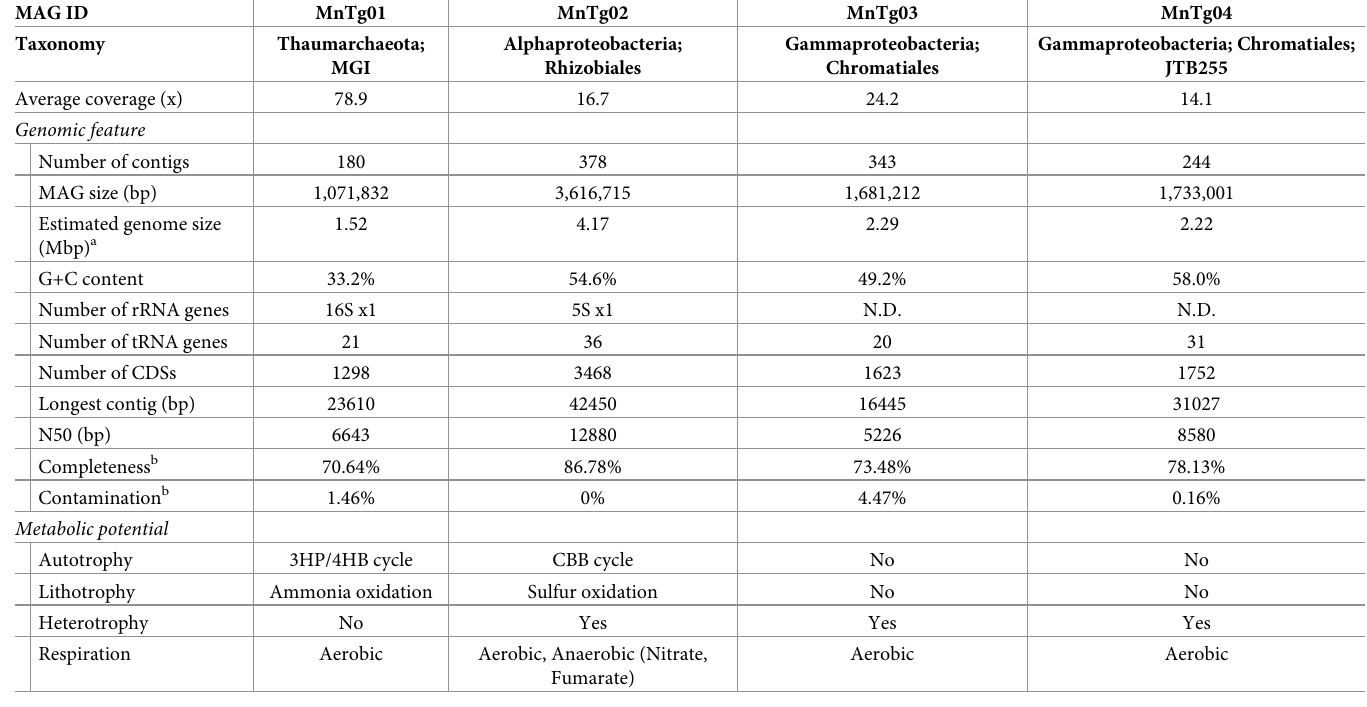
Table 1. Summary of sequence information of the